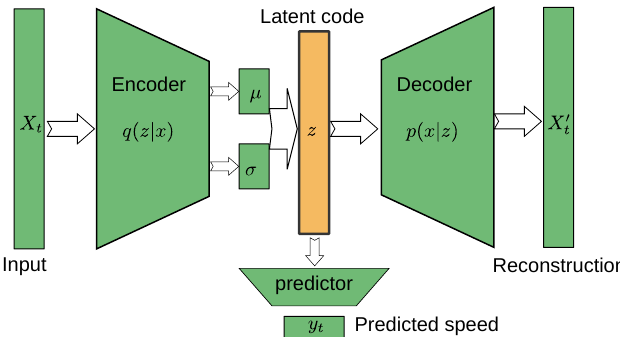
Figure 3. Schematic architecture of semi-supervised variational autoencoder. The path from the input X t to y t corresponds to the feed-forward path; the path from the input X t to prediction X (cid:48)